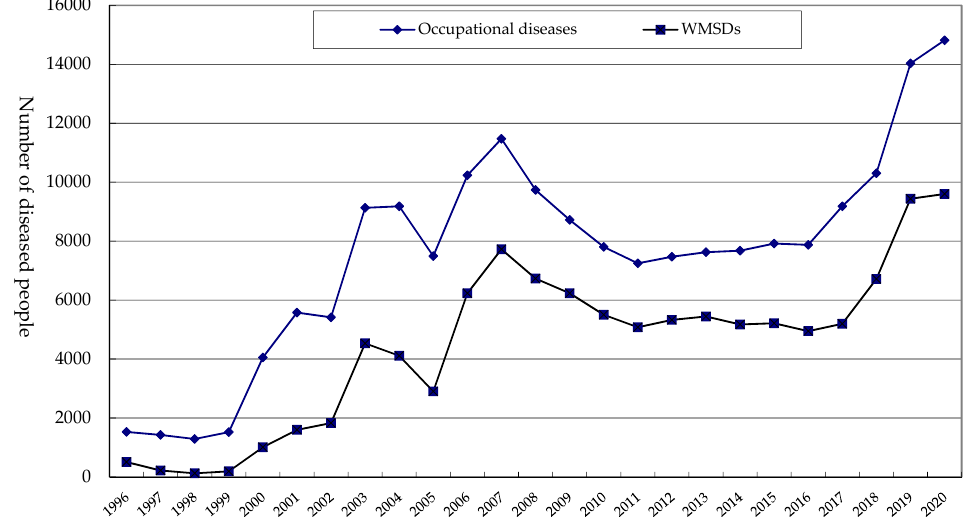
Figure 1. Trends for occupational diseases and WMSDs by year.